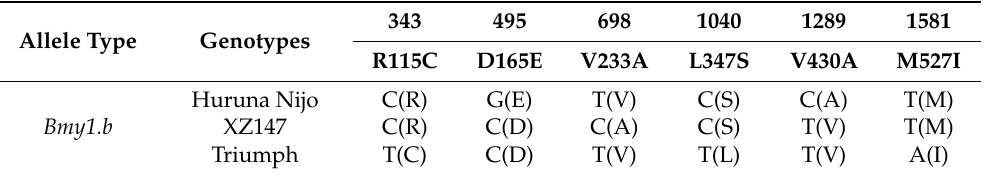
Table 3. mRNA and amino acid sequence alignment of the Bmy1 gene from a cultivated barley Triumph and a wild barley XZ147. Huruna Nijo was used as the